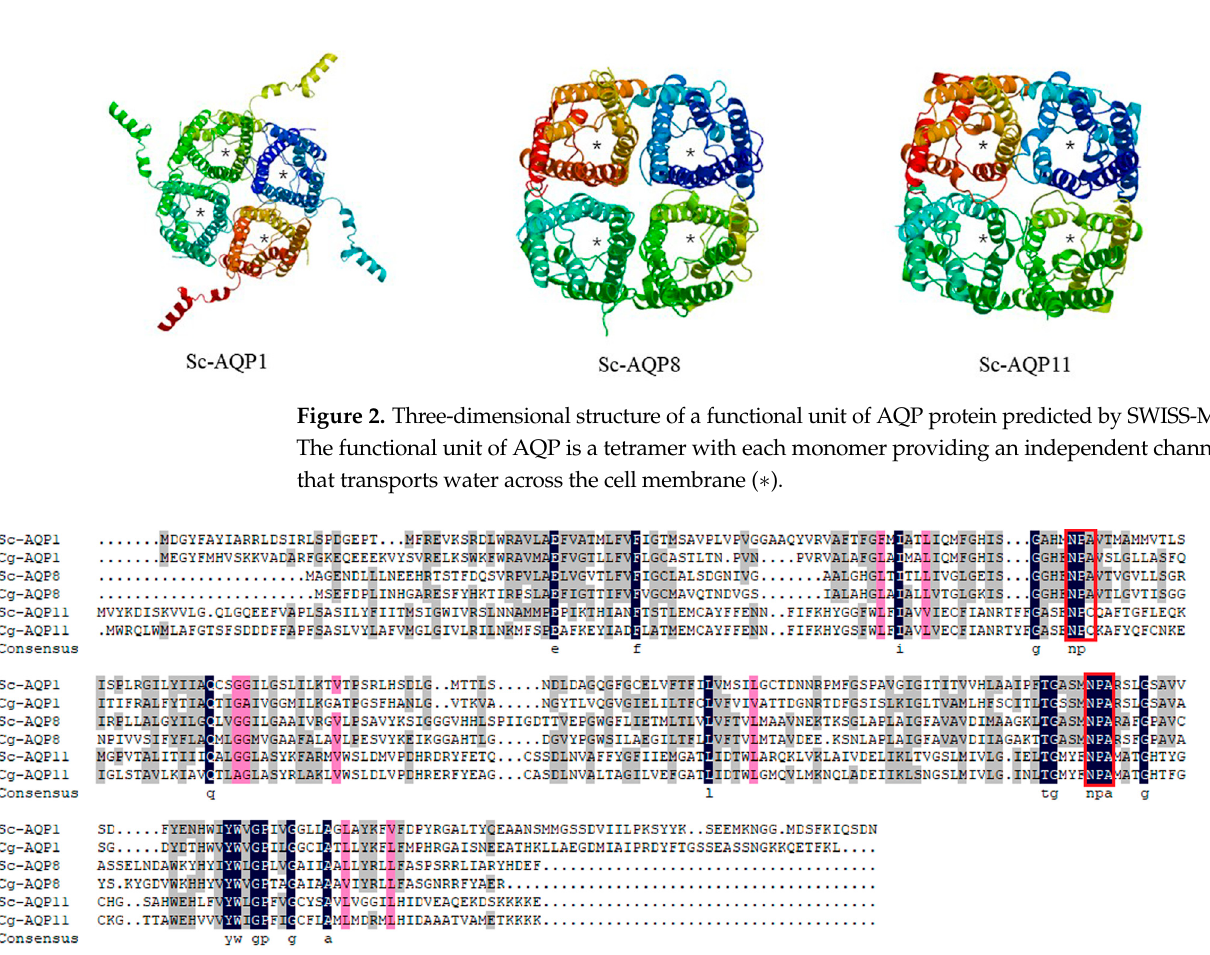
Figure 3. Alignment of the amino acid sequences among Sc -AQP1, Sc-AQP8, Sc -AQP11, Cg -AQP1, Cg -AQP8, and Cg -AQP11. The aligned sequences are as follows: Sc-AQP1, QIE08067.1; Sc -AQP8, QIE08068.1; Sc -AQP11, QIE08069.1; Cg-AQP1, XP_011446842.2; Cg-AQP8, XP_011436665.2; Cg -AQP11, XP_019923893.2. Cg indicated the Crassostrea gigas (Thunberg, 1793). Identical (dark blue) and similar (pink and gray) residues were indicated. Conserved NPA and NPC motifs are marked with the red frame. The pairwise comparison showed that the amino acid sequence of Sc -AQP1